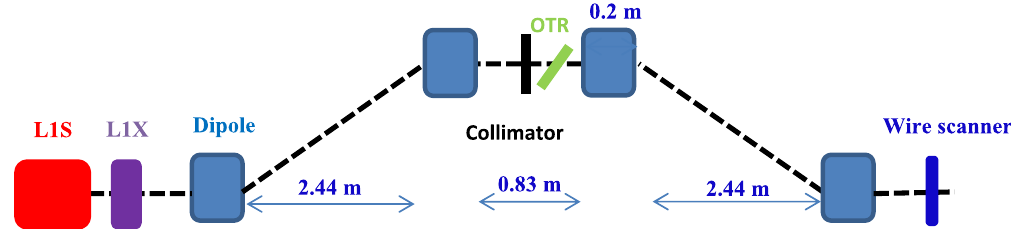
FIG. 5. Sketch of the LCLS first chicane, BC1 (not scaled). The linac L1S is used to introduce an energy-time correlation needed for bunch compression at BC1, while the x -band linac L1X is used to linearize longitudinal phase space. The wire scanner for emittance measurements is located just downstream of BC1. Each bend length is 0.2 m and bending radius is 2